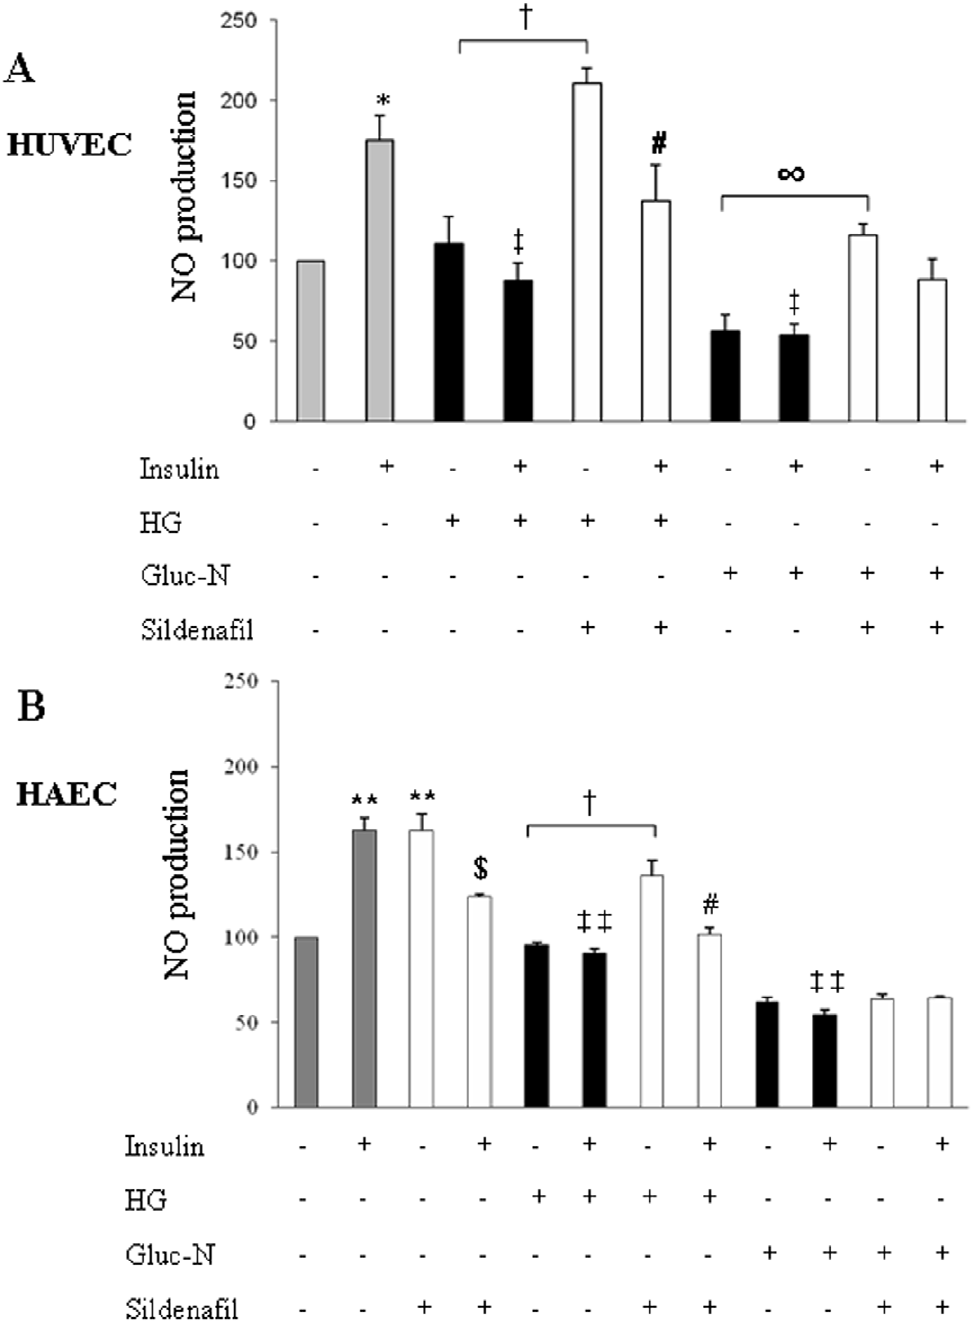
Figure 5. NO production in insulin-resistance conditions after sildenafil treatment. Sildenafil treatment induces NO production in insulin resistance condition (HG and Gluc-N) in HUVEC (panel A) and HAEC (panel B). Full bars represent conditions without sildenafil, dashed bars represent sildenafil treatment. Means 6 S.E. (n=6). * p , 0.05 and ** p , 0.01 vs Ctrl; { p , 0.05 and {{ p , 0.01 vs insulin; { p , 0.05 vs HG; $ p , 0.05 vs sildenafil; # p , 0.05 vs sildenafil + HG; ‘ p , 0.05 vs Gluc-N.